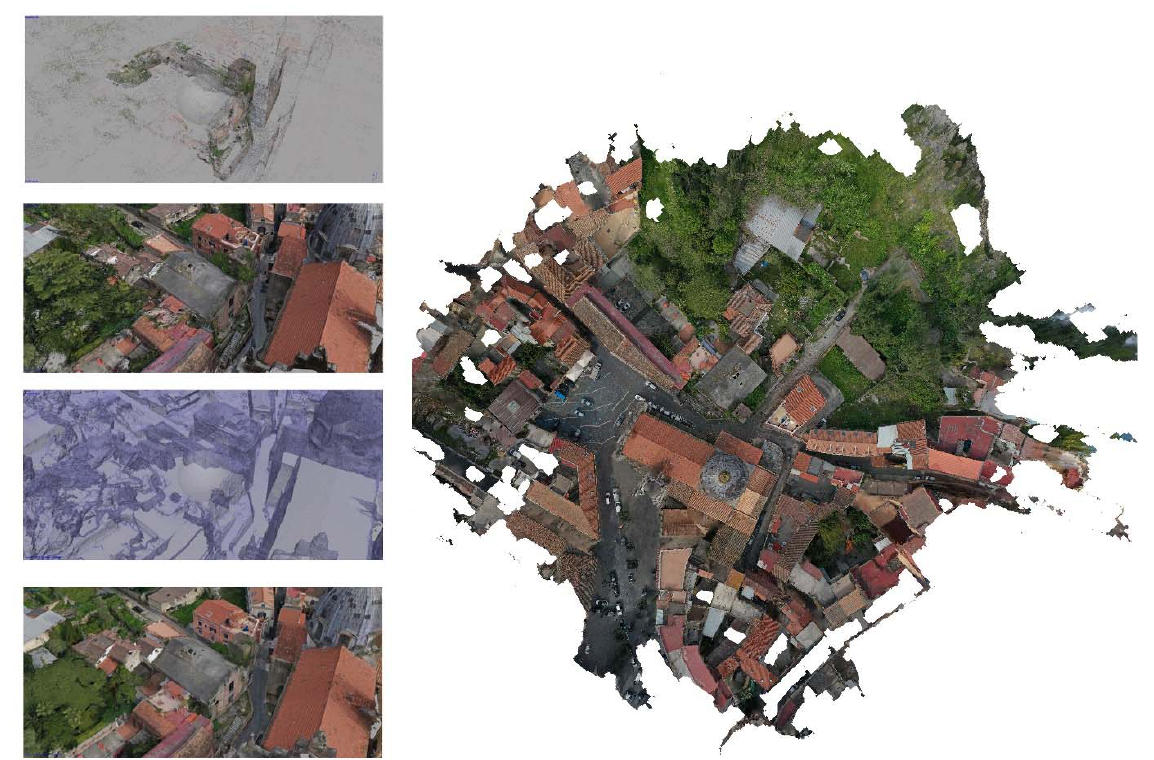
Figure 9. Photogrammetric survey data processing in